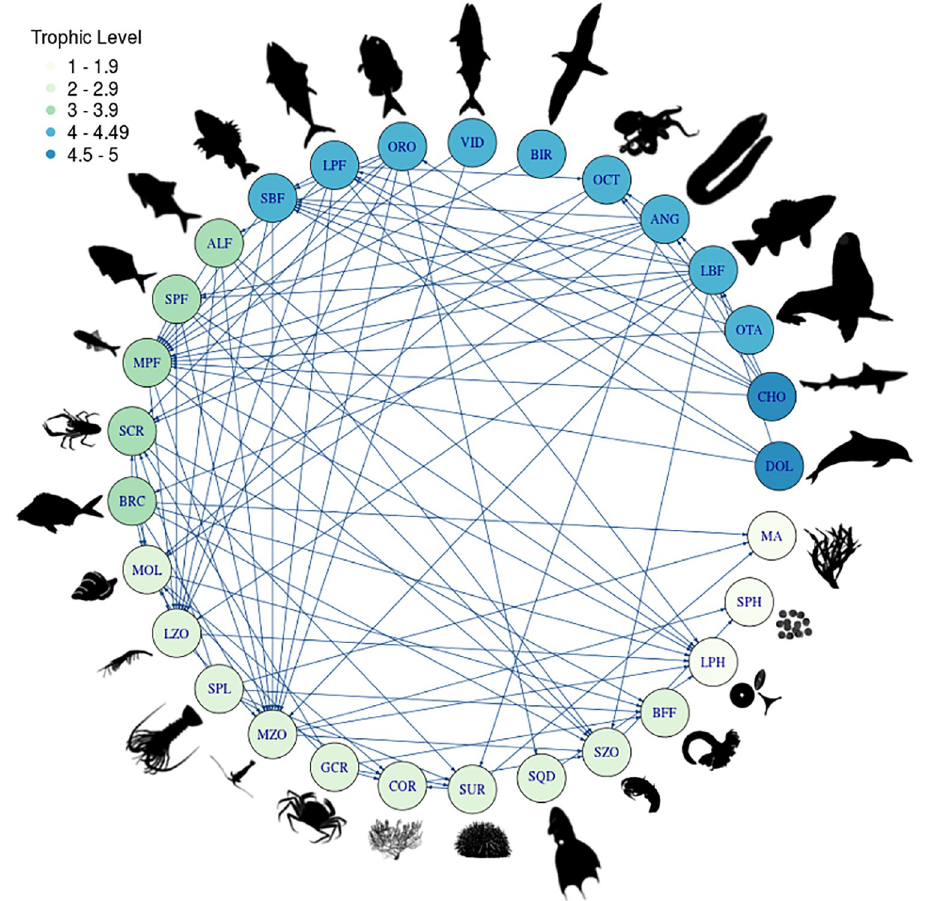
Fig 4. Food web of the Juan Ferna´ndez Ridge ecosystem. The code representing the functional groups can be found in Table 1.